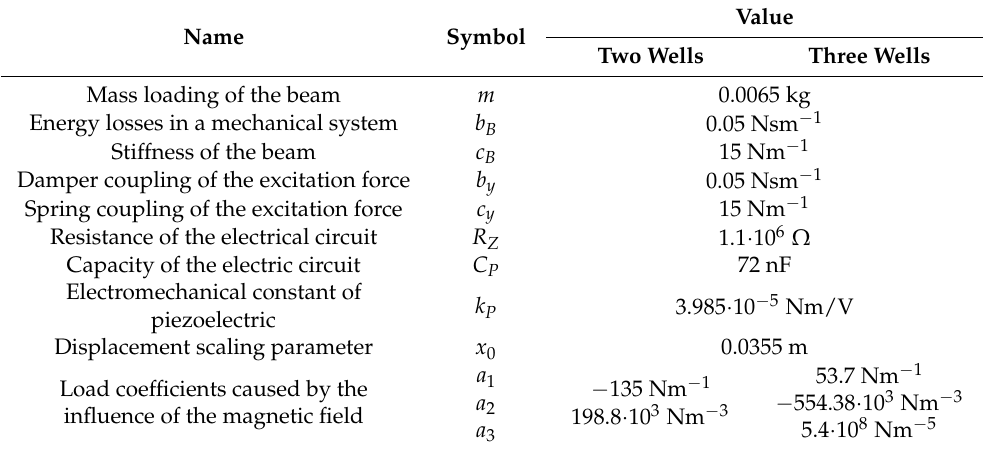
Table 1. Systems’